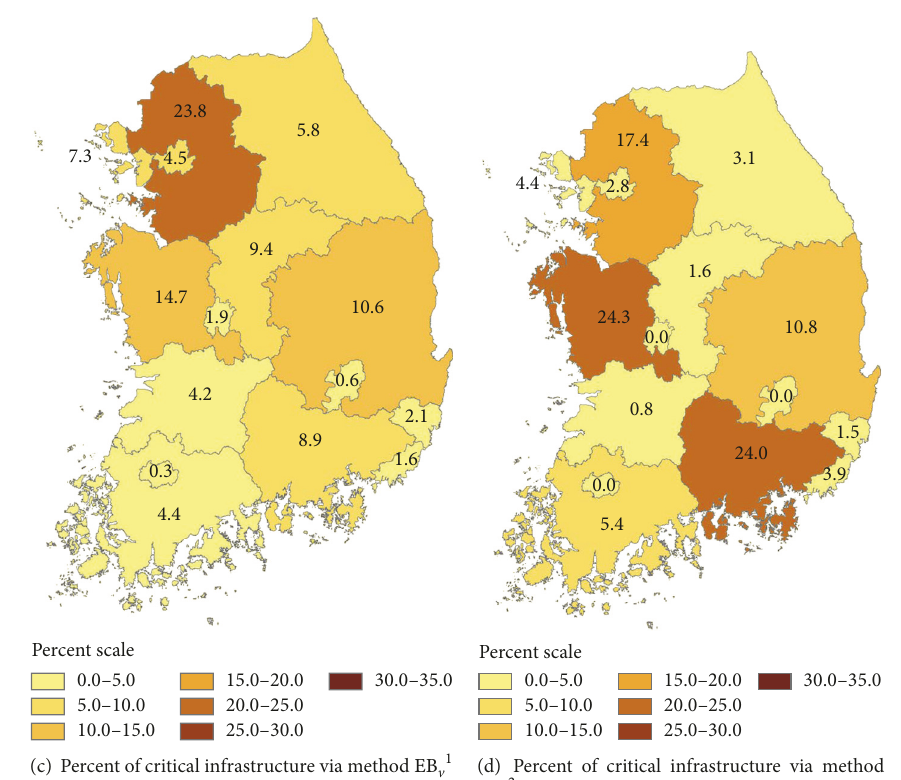
Figure 3: Aggregate criticality scores for Korean power grid infrastructure by emergency management region. The top left image of Korea presents the amount of generation and substation buses located in each region (a), where all other images show the normalized total criticality score for each region (b, c, and d). Thus, percent scale refers to quantity of infrastructure (a) and aggregated criticality score (b, c, and d). Regions are labelled in (a) with abbreviations: Gyeonggi-do (GGD), Gangwon-do (GD), Chungcheongnam-do (CCND), Chungcheongbuk- do (CCBD), Gyeongsangnam-do (GSND), Gyeongsangbuk-do (GSBD), Jeollanam-do (JND), Jeollabuk-do (JBD), Seoul-si (SS), Incheon-si (IS), Daejeon-si (DJS), Gwangju-si (GS), Daegu-si (DGS), Ulsan-si (US), and Busan-si